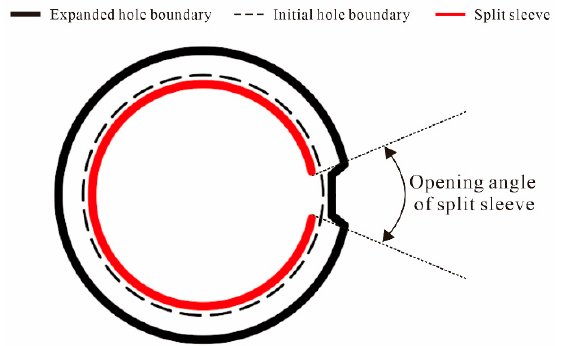
Figure 13. Equivalent von Mises stress of each hole along the x -axis of a three-hole cold-expanded specimen with a hole spacing of four times the diameter of the hole.